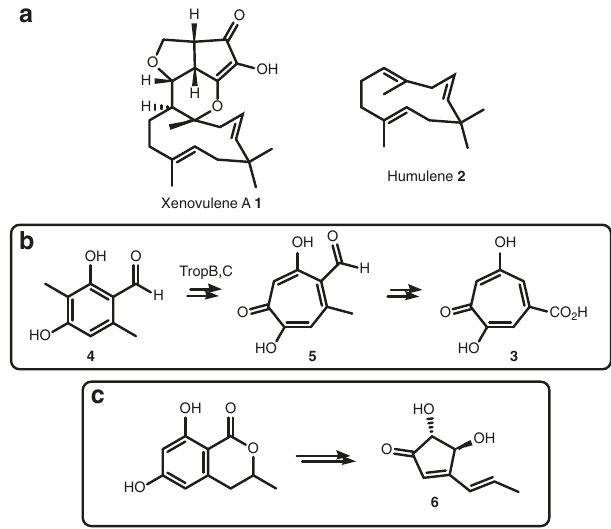
Fig. 1 Xenovulene and related compounds. a Structures of xenovulene A 1 and humulene 2 ; b fungal route to tropolones from methylorcinaldehyde 4